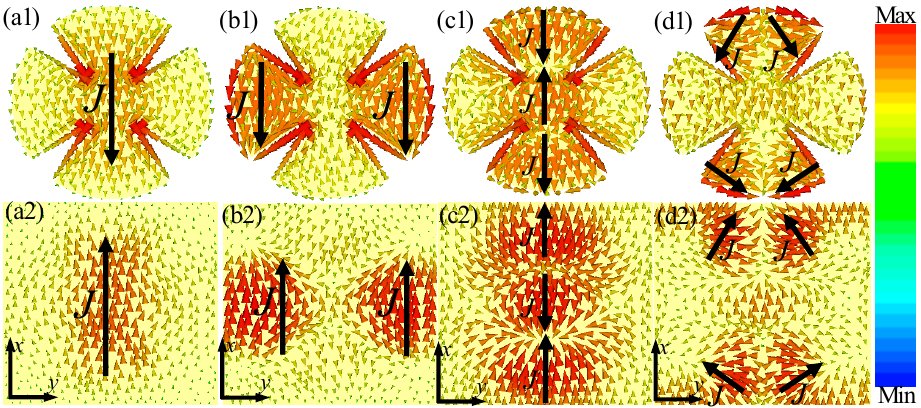
Figure 7. The surface current distributions of the ( a1 – d1 ) front and ( a2 – d2 ) back metallic layers of the unit-cell structure at different resonant frequencies: ( a1 , a2 ) f 1 = 3.56 GHz; ( b1 , b2 ) f 2 = 8.56 GHz; ( c1 , c2 ) f 3 = 12.42 GHz; and ( d1 , d2 ) f 4 = 15.04 GHz. The solid arrow indicates the flow directions of surface currents at the two metallic layers.